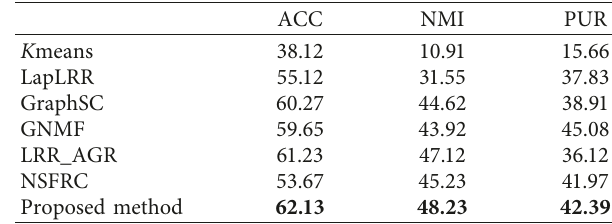
Table 6: Clustering results of different algorithms on BBC